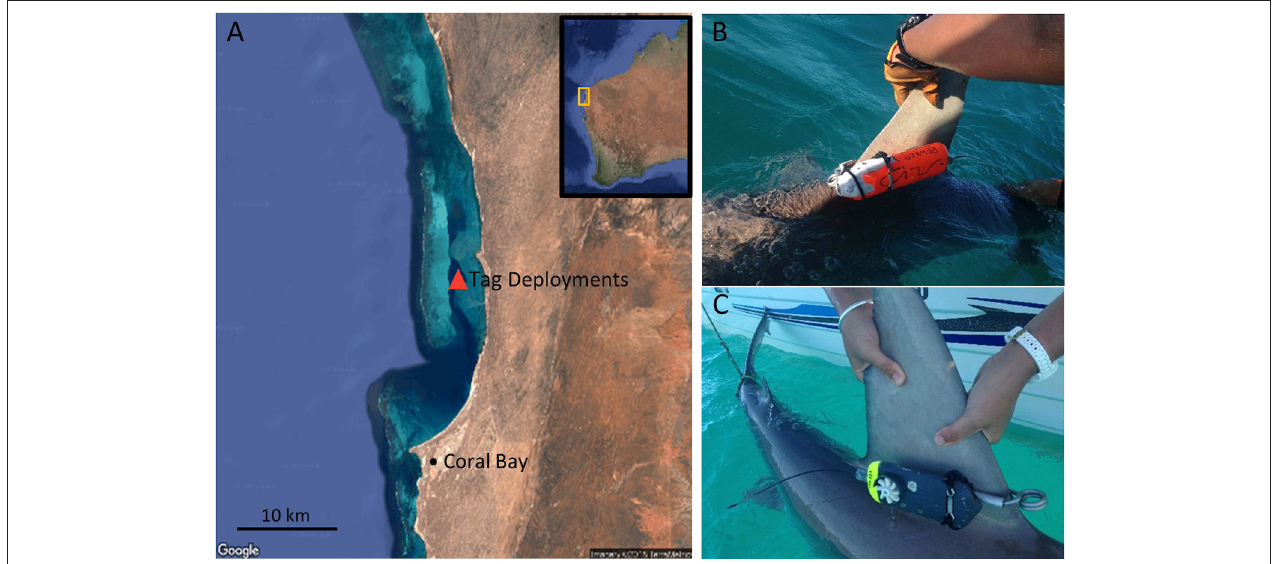
FIGURE 1 | Tagged sandbar sharks at Ningaloo Reef. (A) Location of tag deployments. (B) CATS Cam tag clamped to the dorsal fin. (C) CATS Diary tag clamped to the dorsal fin.